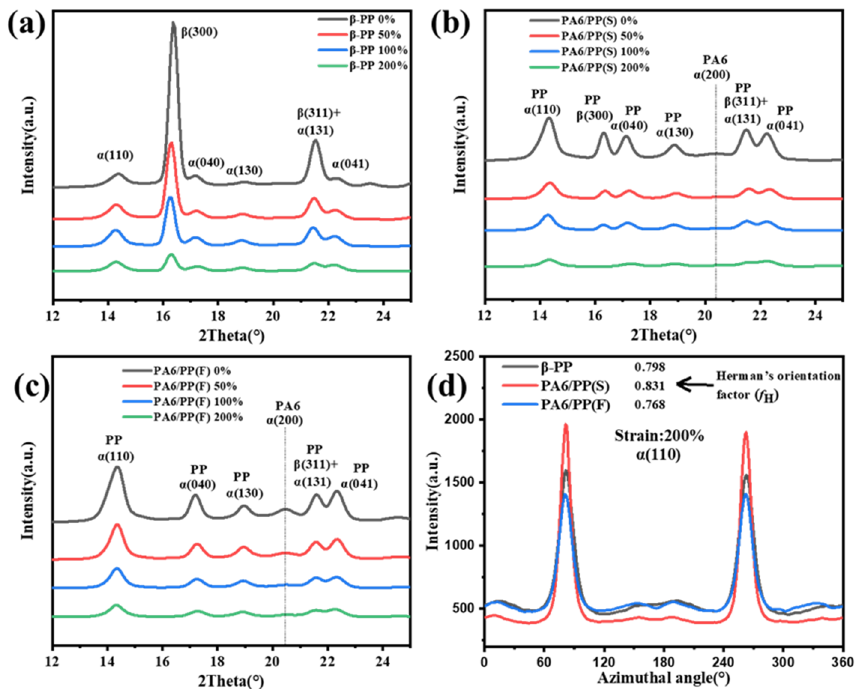
Figure 8. One-dimensional-WAXD curves integrated from two-dimensional-WAXD patterns of ( a ) β -PP, ( b ) PA6/PP(S), and ( c ) PA6/PP(F). ( d ) α (110) intensity distribution with the azimuthal angle at ε = 200%.